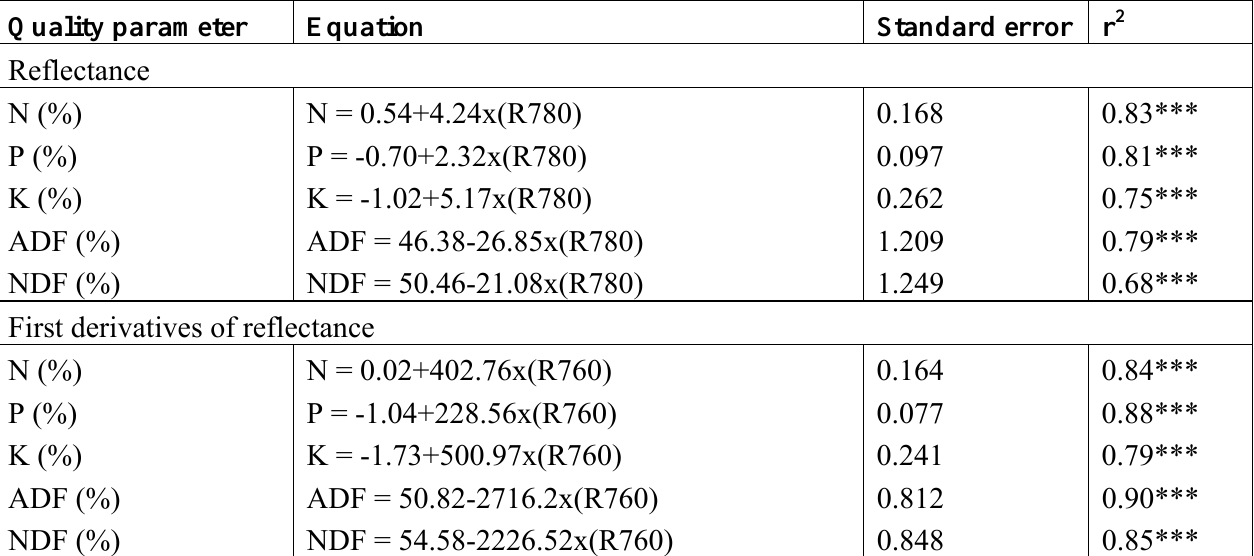
Table 4. Near infrared wavebands (±5) selected from linear regression for determining relationships between reflectance and nutrition contents on the basis of calibration data set in sainfoin